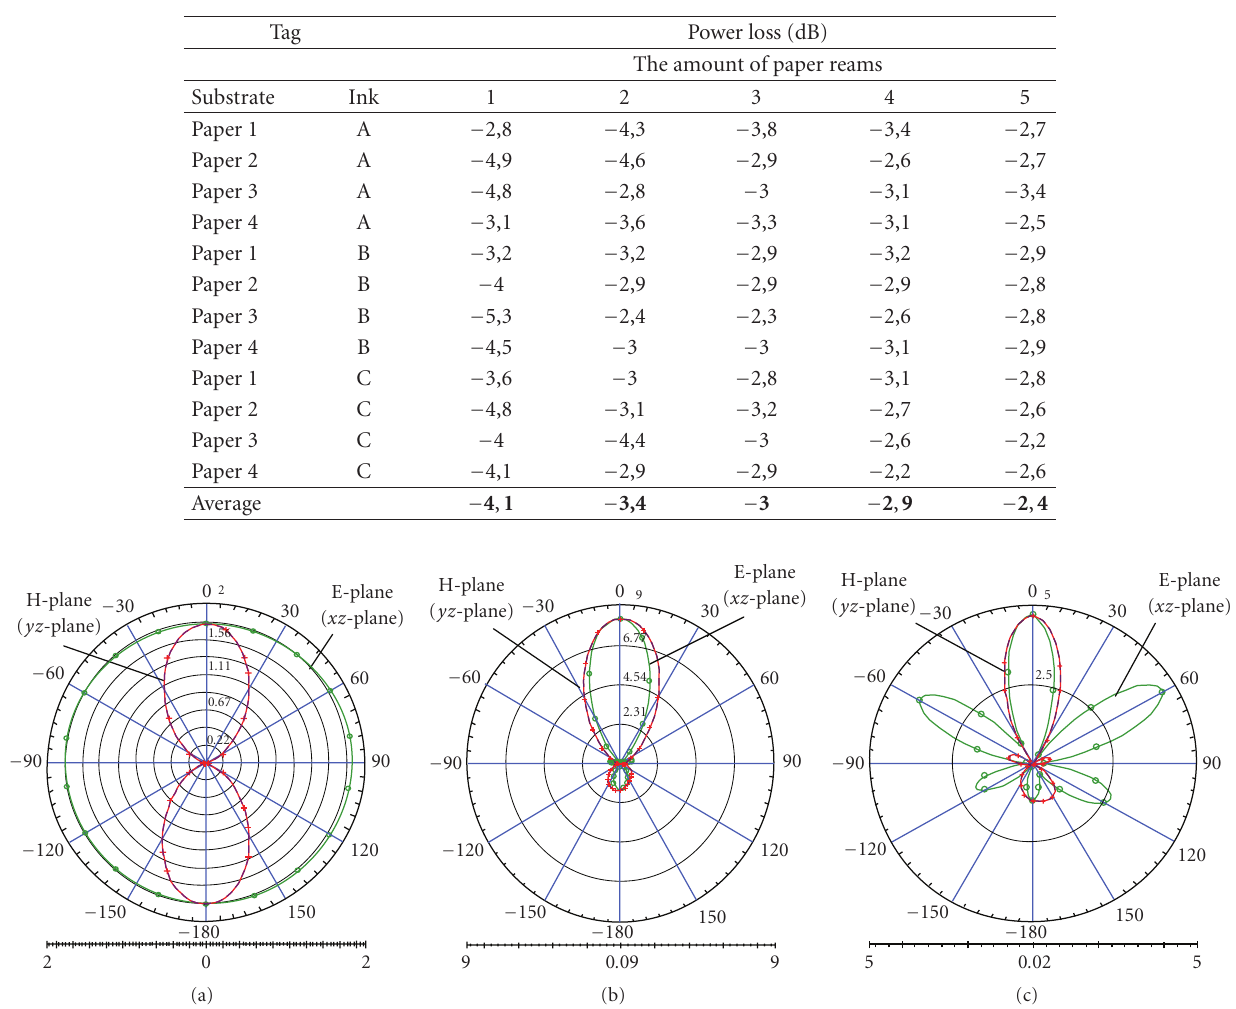
Table 8: The power losses related to measurement results presented in Table 7.